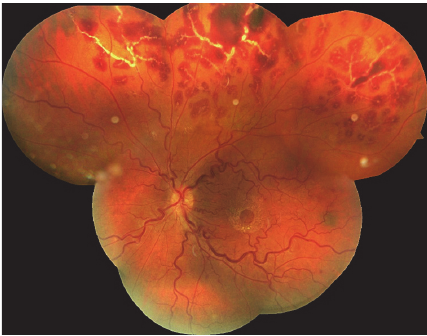
Figure 3: Recurrence of frosted branch angiitis. Fundus image shows vascular sheathing and preretinal and intraretinal hemor- rhages limited to the superior peripheral